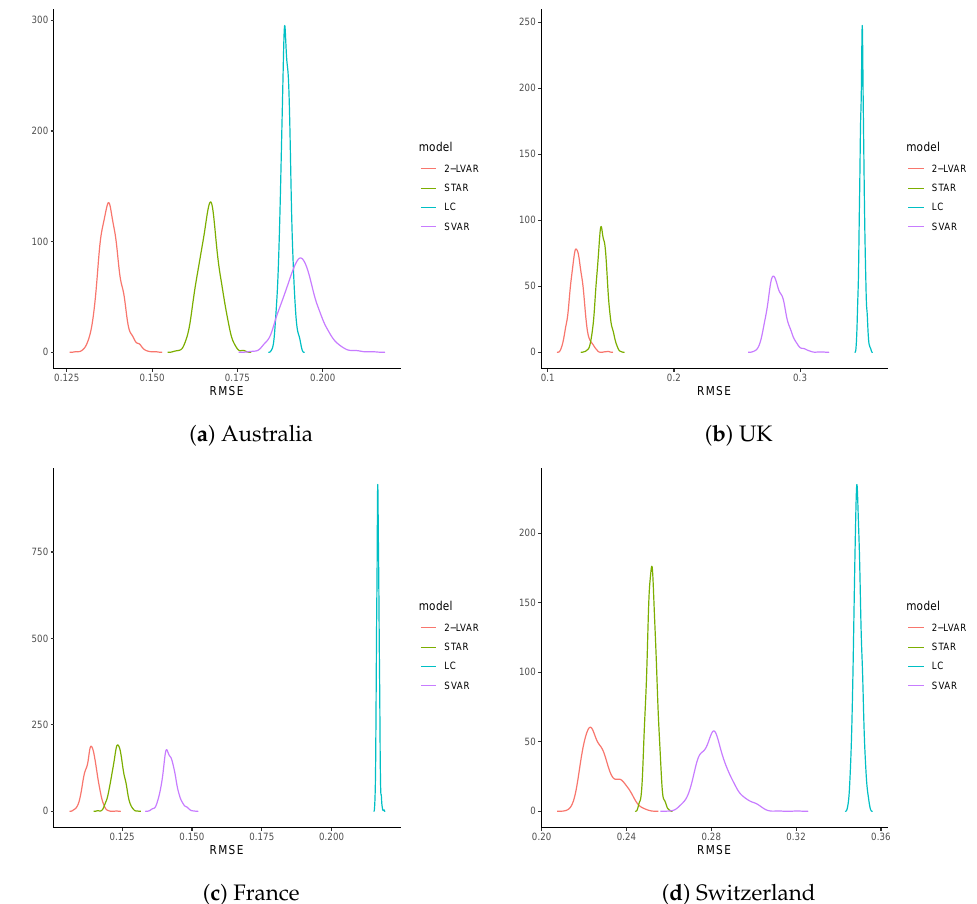
Figure 5. Density plots of RMSEs of simulated mortality rates of Australia, the UK, France, and Switzerland. The curves are based on smoothed densities produced by the 1000 RMSE all ,16 for each